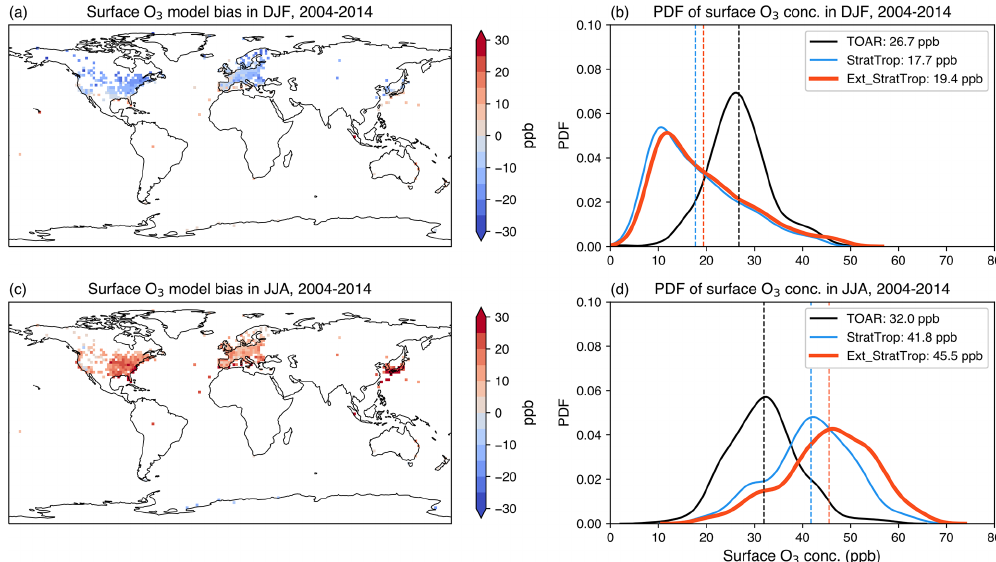
Figure 2. Modelled surface O 3 biases with the Ext_StratTrop chemistry scheme for winter (DJF) and summer (JJA) over 2004–2014 (a, c) . Probability distribution function (PDF) of seasonal mean O 3 mixing ratios between observations, StratTrop, and Ext_StratTrop chemistry schemes (b, d) . Vertical dashed lines indicate seasonal mean surface O 3 mixing ratios. Observations from the Tropospheric Ozone Assess- ment Report (TOAR) dataset (Schultz et al., 2017a) are used for